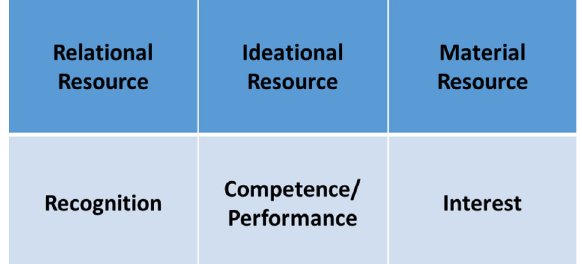
FIG. 1. The constructs drawn from to develop the Critical Physics Identity framework. The bottom gray row shows con- structs drawn from the physics identity framework [3]. The top blue row shows the constructs drawn from the racialized identity resources framework